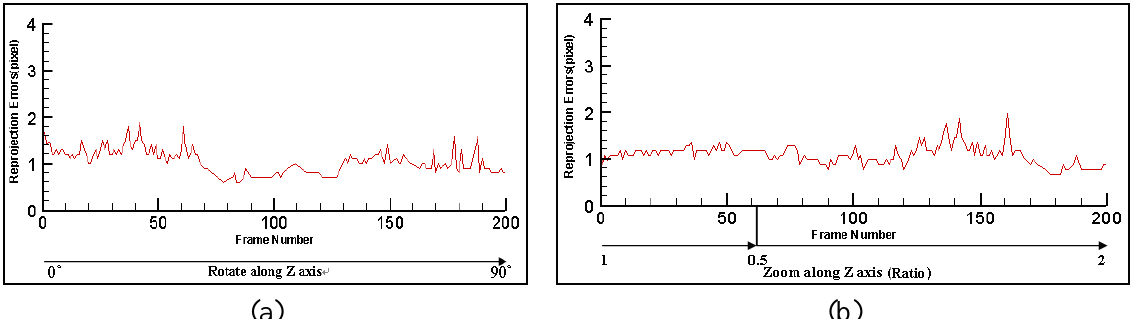
Figure 10. Reprojection